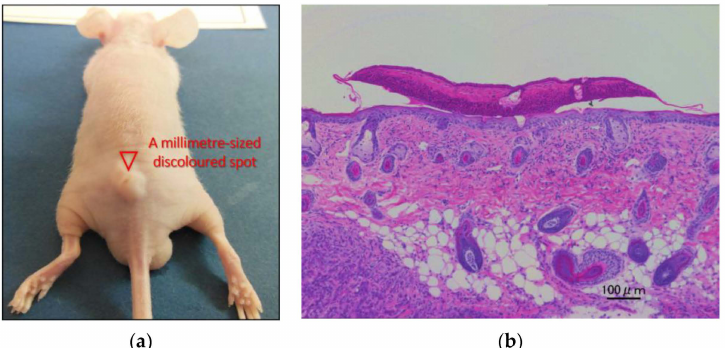
Figure 1. ( a ) Photograph of a seven-week-old female BALB/c nu/nu mouse with a subcutaneous cancer tumour following 15 min helium plasma jet treatment. The triangle indicates a millimetre-sized discoloured spot created in the plasma-treated region on the skin above the subcutaneous tumour. ( b ) Histological cross-section of the discoloured region taken 24 h after the plasma treatment. The microscope image shows a scab, indicating a wound created in the discoloured